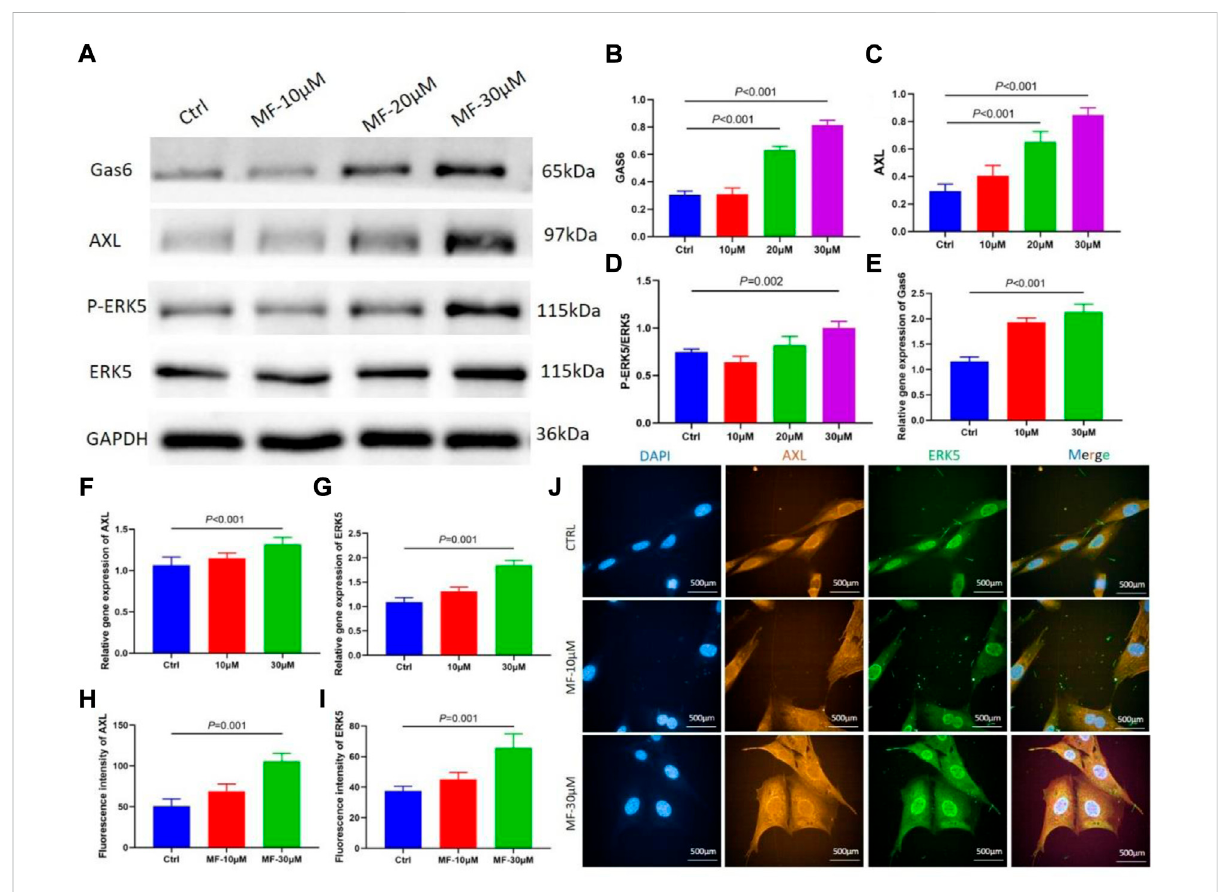
FIGURE 4 (A – D) Whencomparedwiththecontrolgroup,theproteinlevelofGas6andAXLsigni fi cantlyincreasedwhentheconcentrationwas10,20,and 30 μ M ( p < 0.05, respectively). The ratio of P-ERK5/ERK5 signi fi cantly increased when the concentration was 30 μ M ( p < 0.01). (E – G) qRT-PCR showed that the relative gene expressionof Gas6, AXL, and ERK5 signi fi cantly increased in themangiferingroup when the concentration was 30 μ M (whencomparedwiththecontrolgroup, p < 0.01). (H – J) Theimmuno fl uorescenceofAXLandERK5whentheMC3T3-E1cellswereintervened by 10 μ M and 30 μ M mangiferin. When compared with the control group, the AXL and ERK5 signi fi cantly increased in the 30 μ M ( p < 0.01, respectively) Note: MF, Mangiferin. Ctrl, osteogenic induction